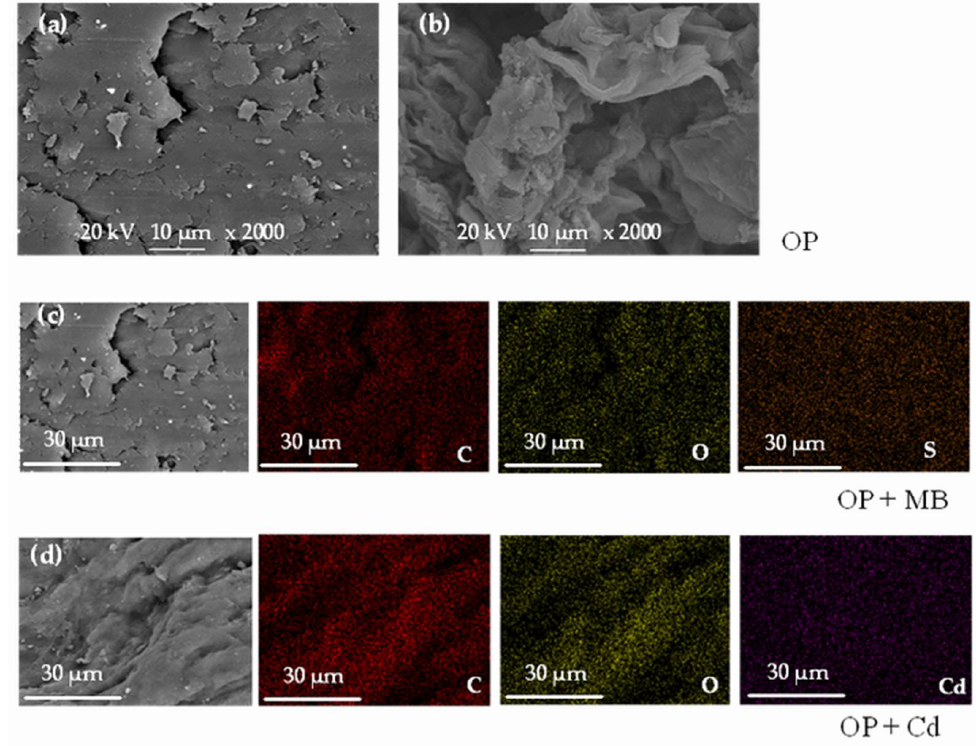
Figure 3. SEM-EDS elemental mapping of OP after MB and Cd 2+ adsorption in monocomponent systems. The element distributions were represented by colors red (carbon), yellow (oxygen), orange (sulfur), and violet (cadmium). ( a , b ) SEM images of OP at × 2000 magnification. ( c ) SEM-EDS images of OP sample after MB adsorption, and ( d ) SEM-EDS images of OP sample after Cd 2+